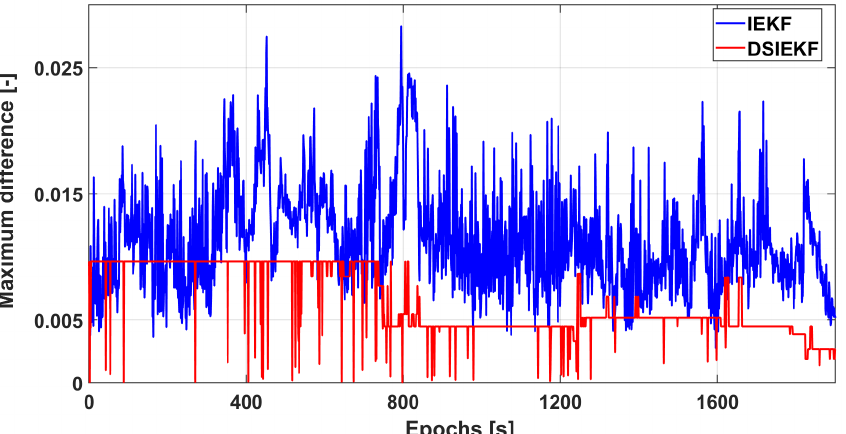
Figure 13. The maximum difference between the estimated normal vectors of the planes by means of the algorithms and the available information from the 3D city model.